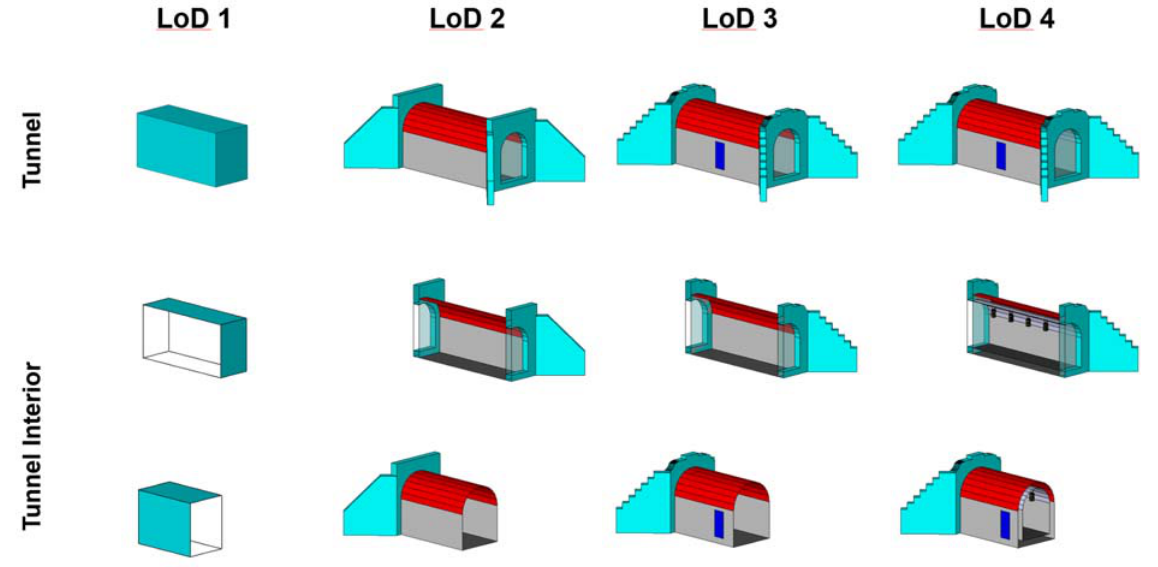
Figure 2. Illustration of the geometric representation of tunnels on different LoDs (Source: (Gröger et al.